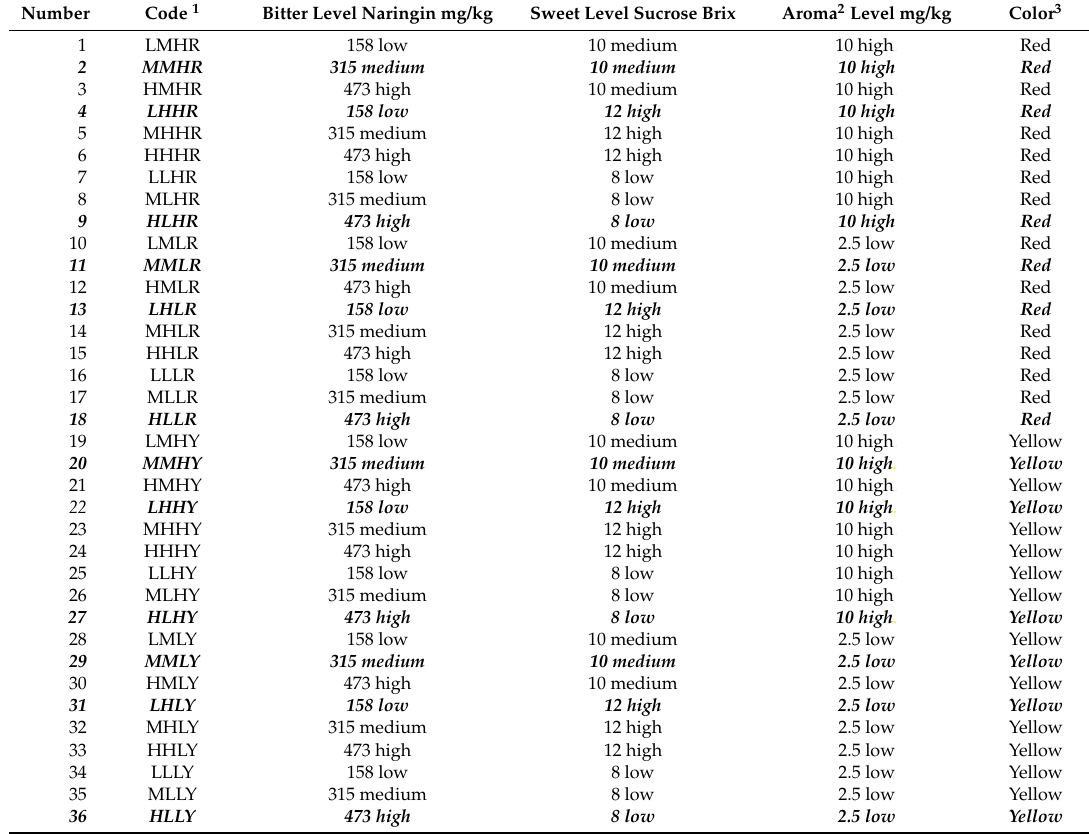
Table 1. Factorial design for the 36 grapefruit-like